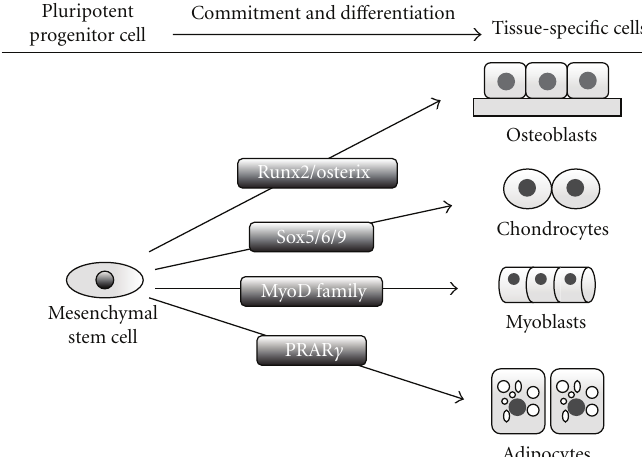
Figure 2: A schematic model for the di ff erentiation of mesenchymal stem cells into tissue-specific cells by specific transcriptional factors. Mesenchymal stem cells can di ff erentiate into osteoblasts,chondrocytes, myoblasts,and adipocytes. Each di ff erentiation programis regulated by specific transcription factors: Runx2/Osterix, Sox5/6/9, MyoD family, and PPAR γ ,